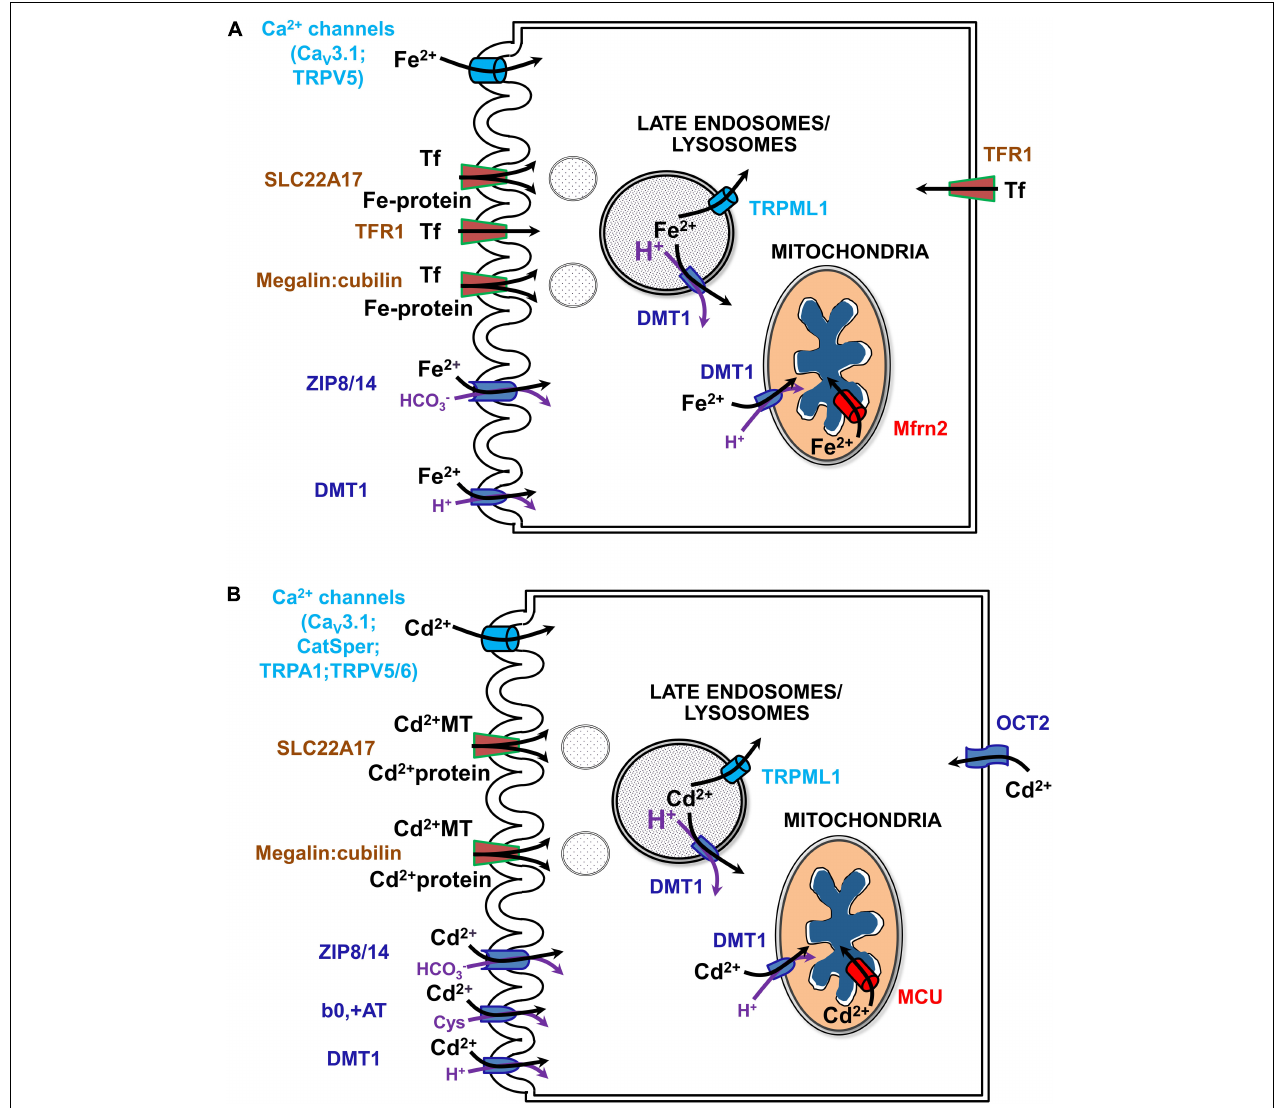
FIGURE 4 | Uptake pathways for Fe (A) and Cd (B) via channels, solute carriers (SLCs) and receptors in renal epithelial cells. See text and (Thévenod and Wolff, 2016; Thévenod et al., 2019; Van Swelm et al., 2020) for further details. b0,+AT, amino acid/cystine transporter (SLC7A9/SLC3A1); CatSper, cation channel of sperm; Cav3.1, voltage-gated calcium channel alpha subunit 3.1; DMT1, divalent metal transporter 1 (SLC11A2); MCU, mitochondrial calcium uniporter; megalin:cubilin, the megalin:cubilin:amnionless complex; Mfrn2, mitoferrin 2 (SLC25A28); OCT2, organic cation transporter 2 (SLC22A2); SLC22A17, NGAL/lipocalin 2 receptor; Fe-Tf, holo-transferrin; TfR1, Tf receptor 1; TRPA1, transient receptor potential cation channel subfamily A member 1; TRPML1, transient receptor potential cation channel subfamily ML member 1; TRPV5/6, transient receptor potential cation channel subfamily V members 5/6; ZIP8/14, zinc transporters 8/14 precursors